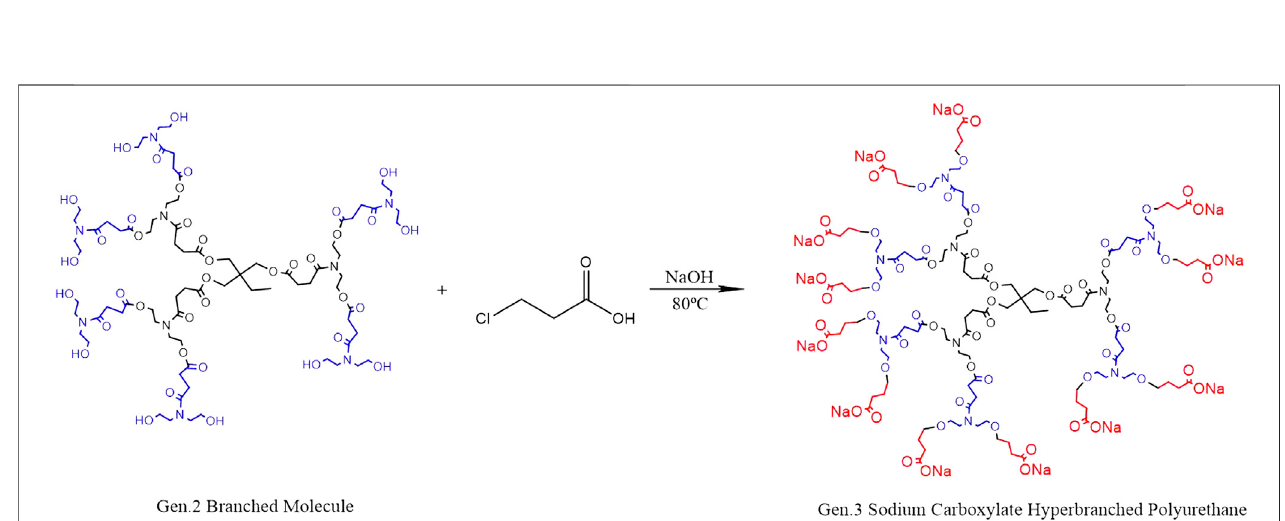
FIGURE 3 | Synthesis of HPAE with sodium carboxylate at the end of Gen.2 ( m -HPAE).